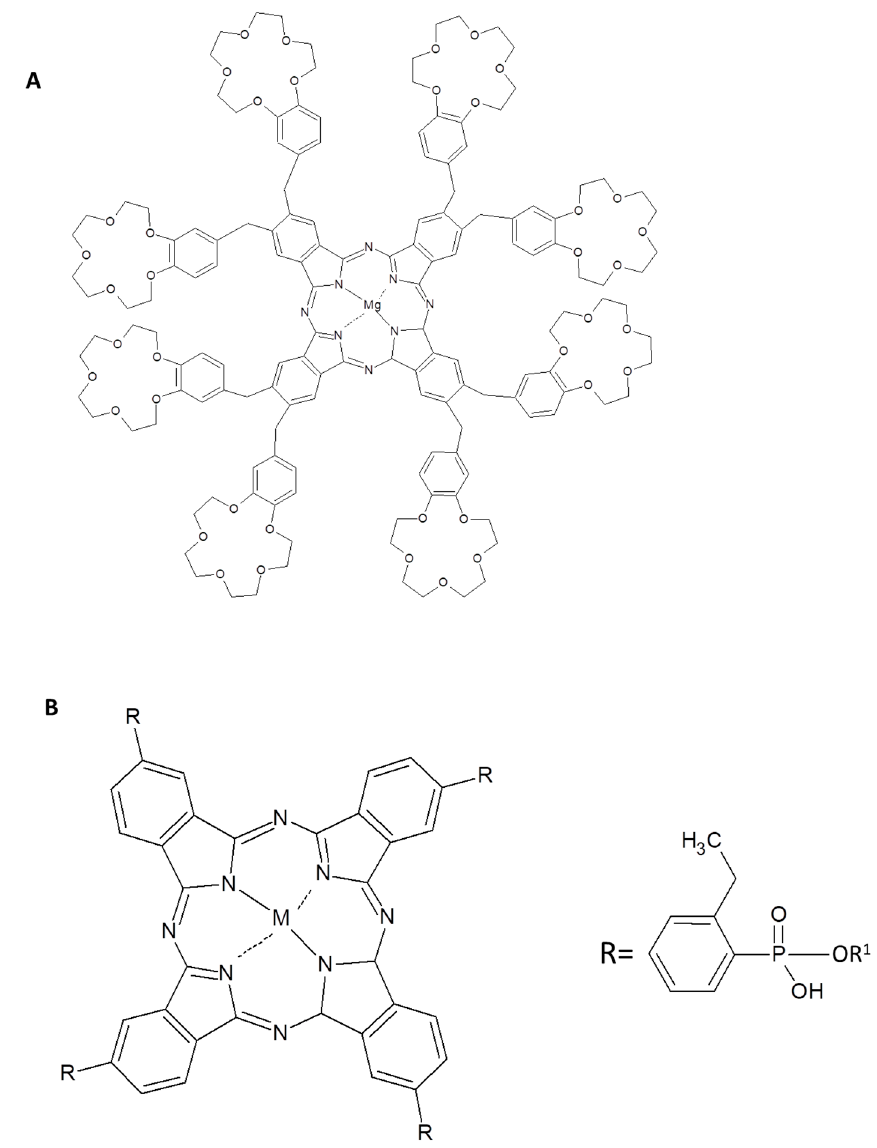
Figure 32. ( A ) crown-ether and ( B ) phosphoryl-containing derivatives [177].